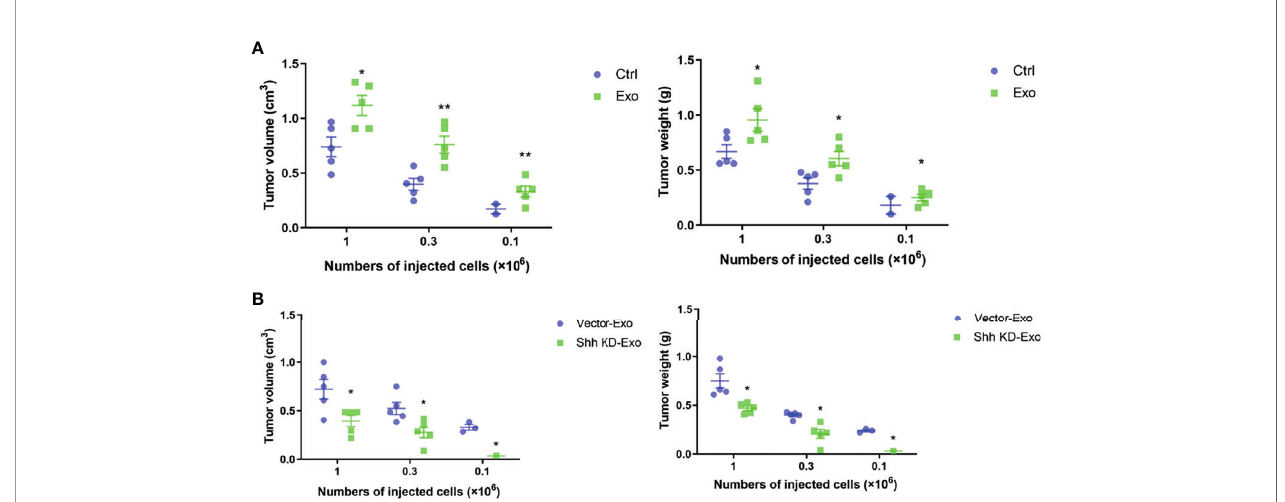
FIGURE 5 | Tumor formations in NOD/SCID mice by PLC/PRF/5. (A) The volume and weight of the tumor formed by PLC/PRF/5 subcutaneously injected into NOD/SCID mice with or without mixed with isolated Exo (5 m g/ml) from the same cell culture medium. (B) The volume and weight of the tumor formed by PLC/PRF/ 5 subcutaneously injected into NOD/SCID mice mixed with Exo (5 m g/ml) isolated from culture medium of the vector or Shh shRNA containing lentivirus transfected cells. * p < 0.05, ** p <